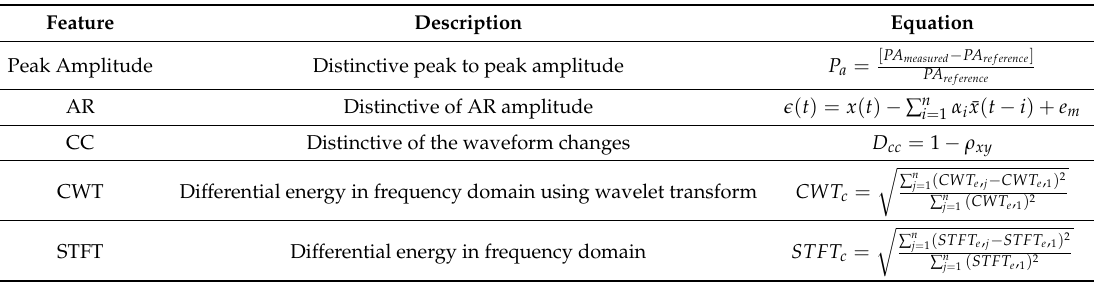
Table 1. Description of the